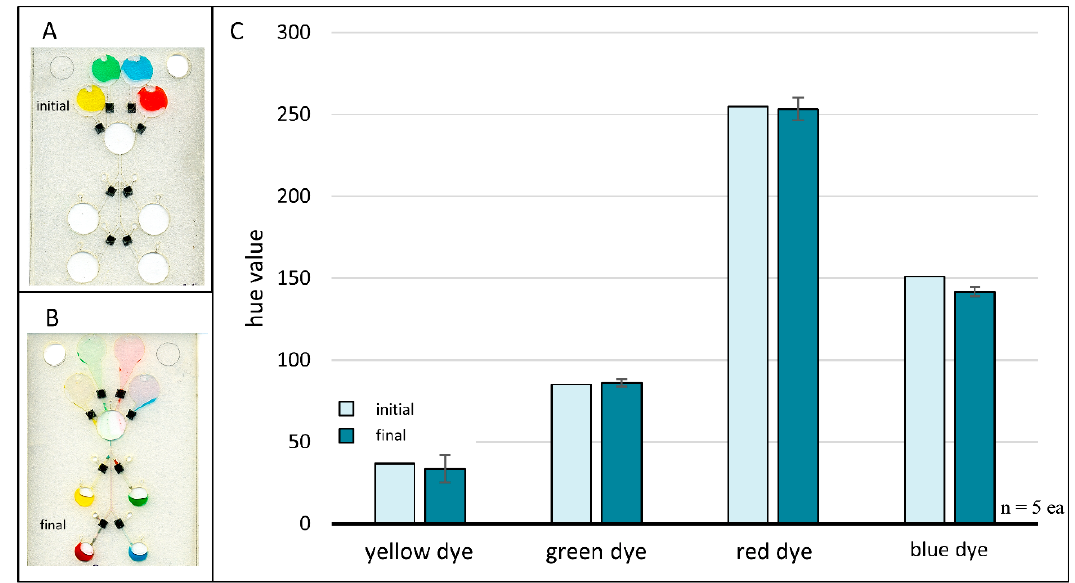
Figure 7. Chloroform redeposition of toner. A loaded four-domain chip prior to any fluid flow or valving events ( A ) and after following completion of all fluid flow and valving events ( B ). Valves were sealed using chloroform for dissolution and redeposition of xerographic toner patches. Scanned images were acquired with an Epson Perfection V100 Photo desktop scanner (Japan). Bar plot ( C ) comparing initial and final hue values for each colored dye. Differences in initial and final hue values were negligible, suggesting successful valve closures via chloroform redeposition of xerographic